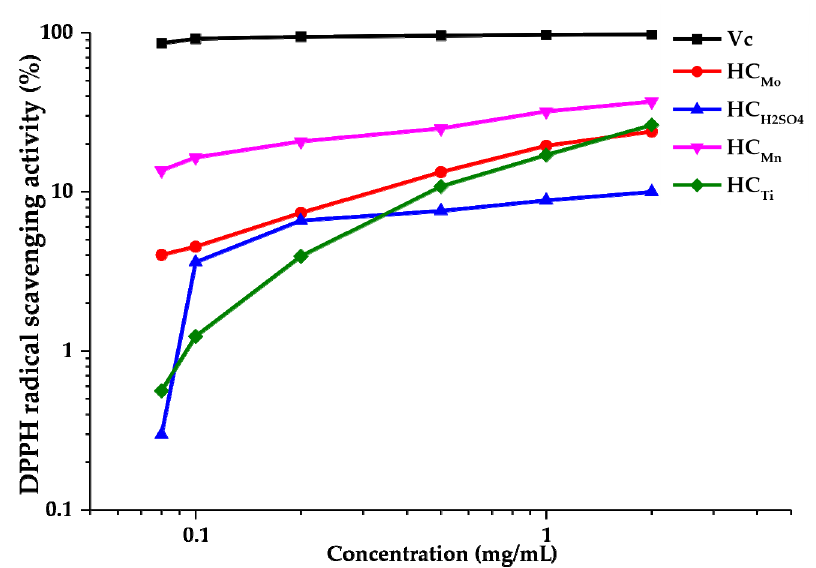
Figure 5. The activity of Vc and HC Mo , HC Mn , HC Ti , and HC H to the DPPH radicals.